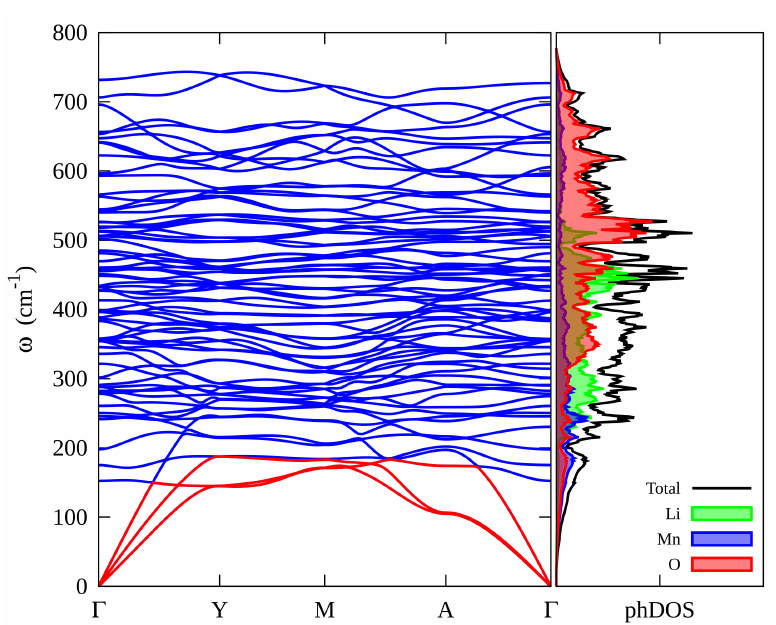
Figure 4. Phonon dispersion and phonon DOS for Li 2 MnO 3 calculated by using the LDA method. In the phonon band structure, the acoustic bands are plotted in